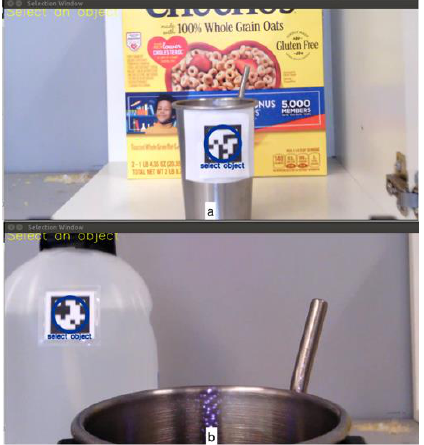
Figure 3. The touchscreen displays an object selection GUI overlayed on the gripper’s camera view. ( a ) shows tag detection with a blue selection circle highlighted to initiate a cup grasp, and ( b ) shows a selectable blue circle that initiates automatically moving the ARM to a jug fill position.